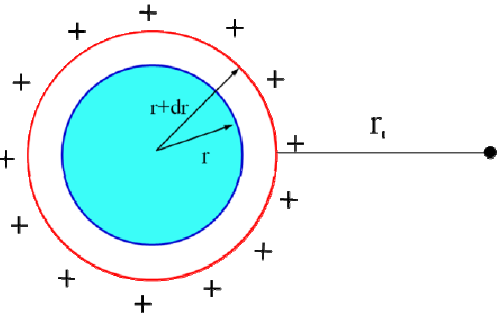
Figure 2. A single droplet holding charges and inducing an electrical